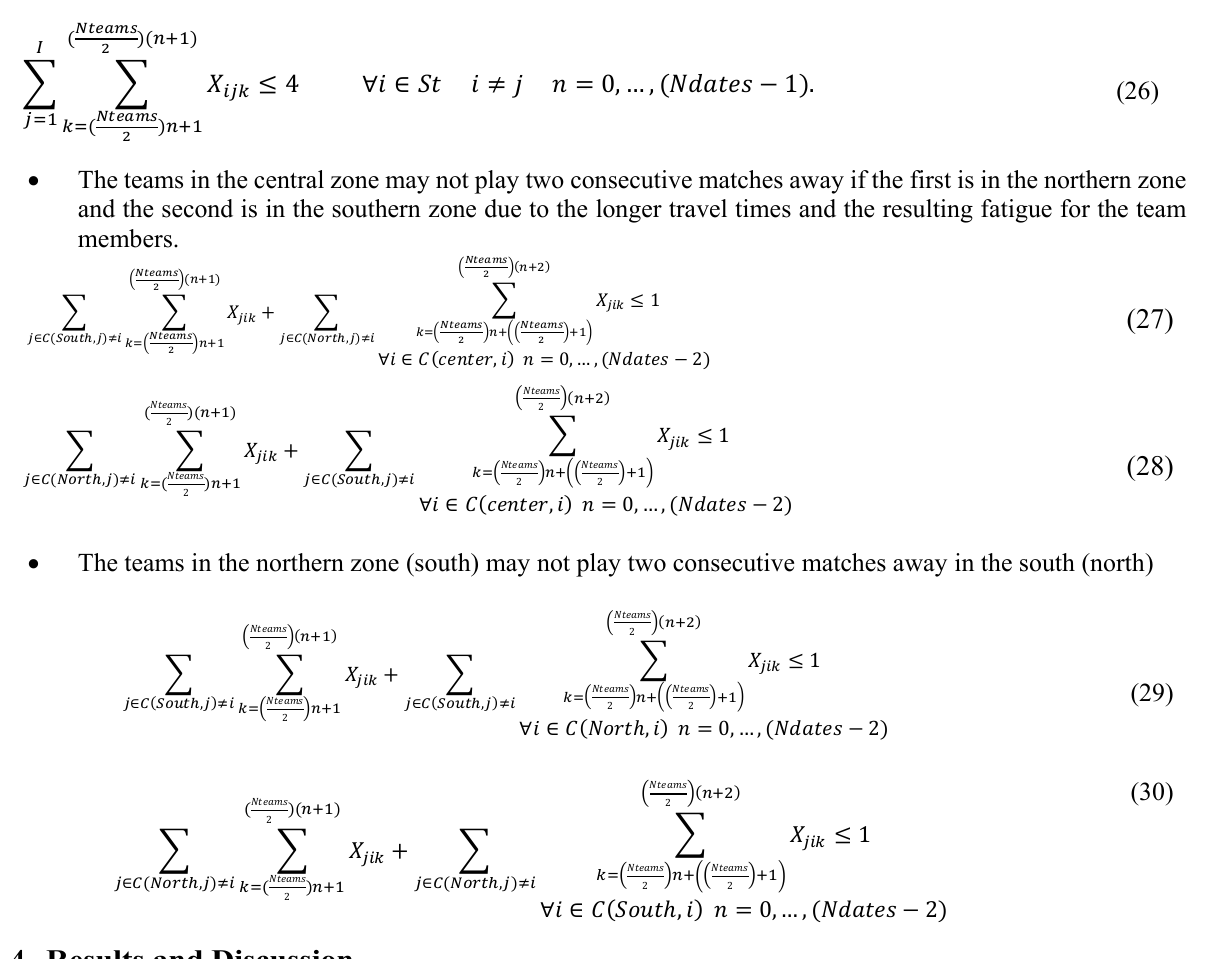
Considered instances. Source: The authors